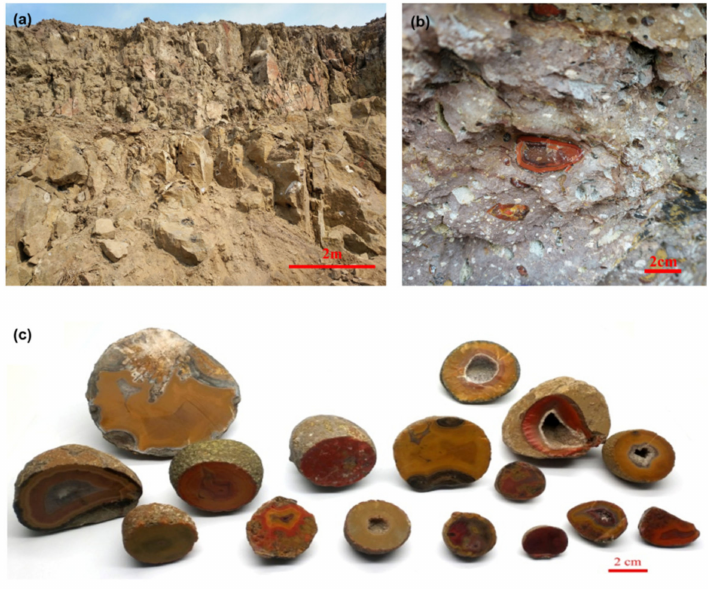
Figure 2. The deposit ( a ), geological occurrence ( b ) and typical samples ( c ) of Xuanhua agate. Temperature dependence of magnetic susceptibility ( χ -T curve) was performed in an Ar atmosphere using KLY-3S Kappa bridge with the CS-3 temperature control system. Samples were heated from 25 ◦ C to 700 ◦ C and cooled back to 25 ◦ C at a rate of 12 ◦ C/min. The heating and cooling curves can provide information on the mineral alternation of the